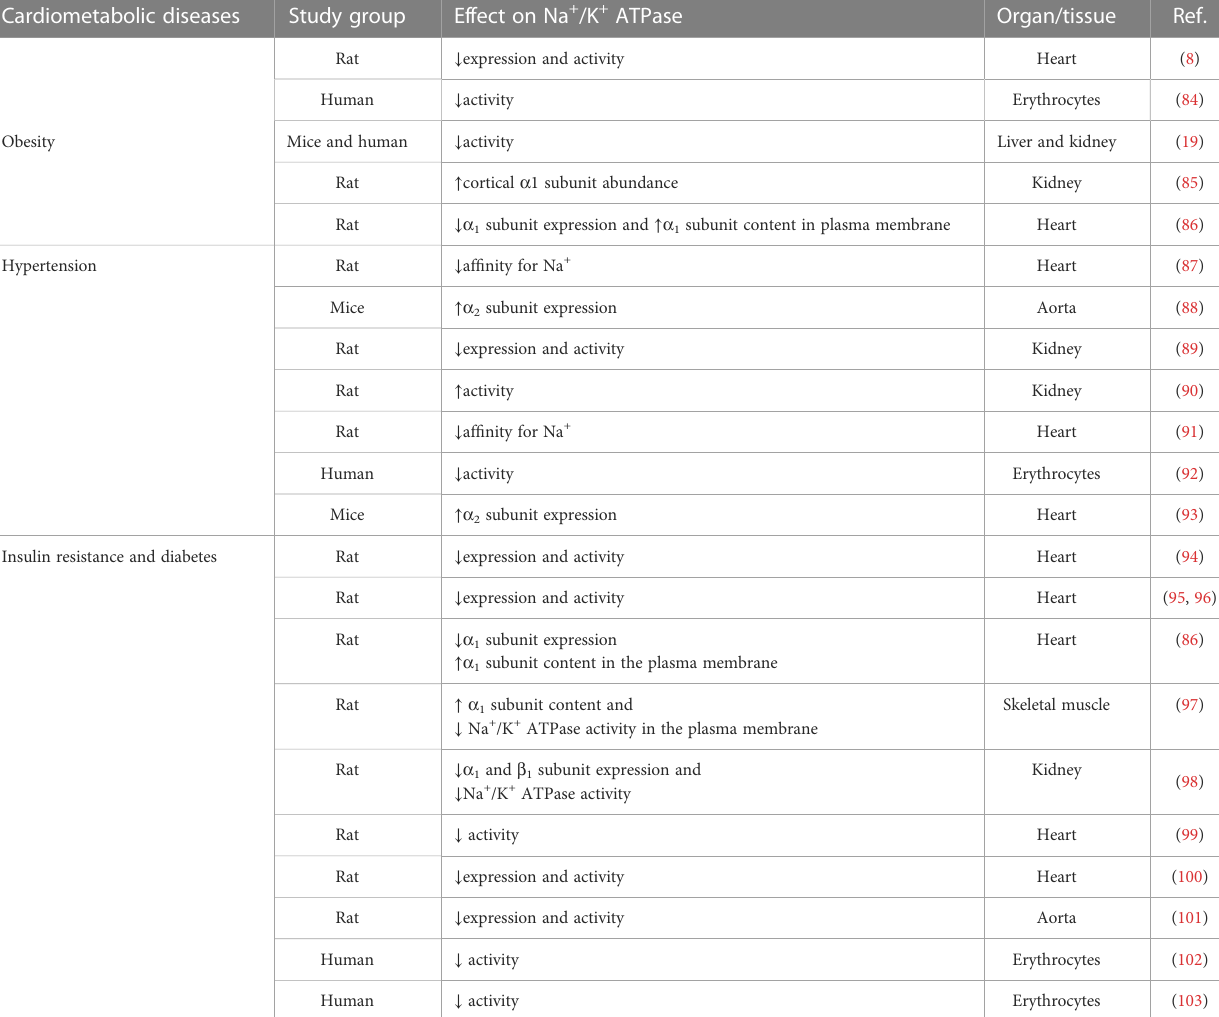
TABLE 1 The link between cardiometabolic diseases and Na + /K + -ATPase